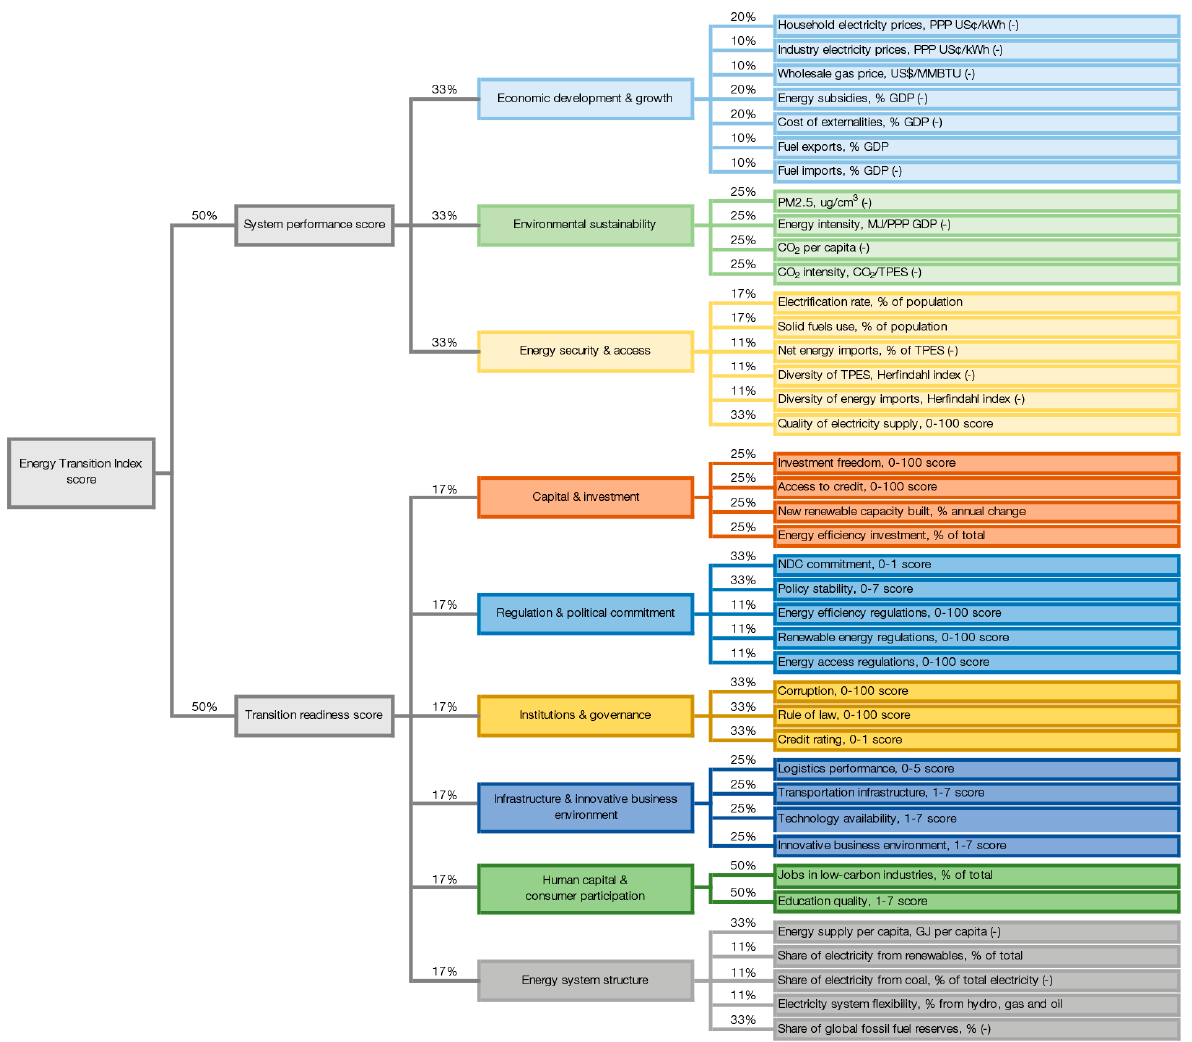
Figure 1. The Main Dimensions of the Energy Transition Index. Reproduced with pemission from [14], World Economic Forum, 2019.